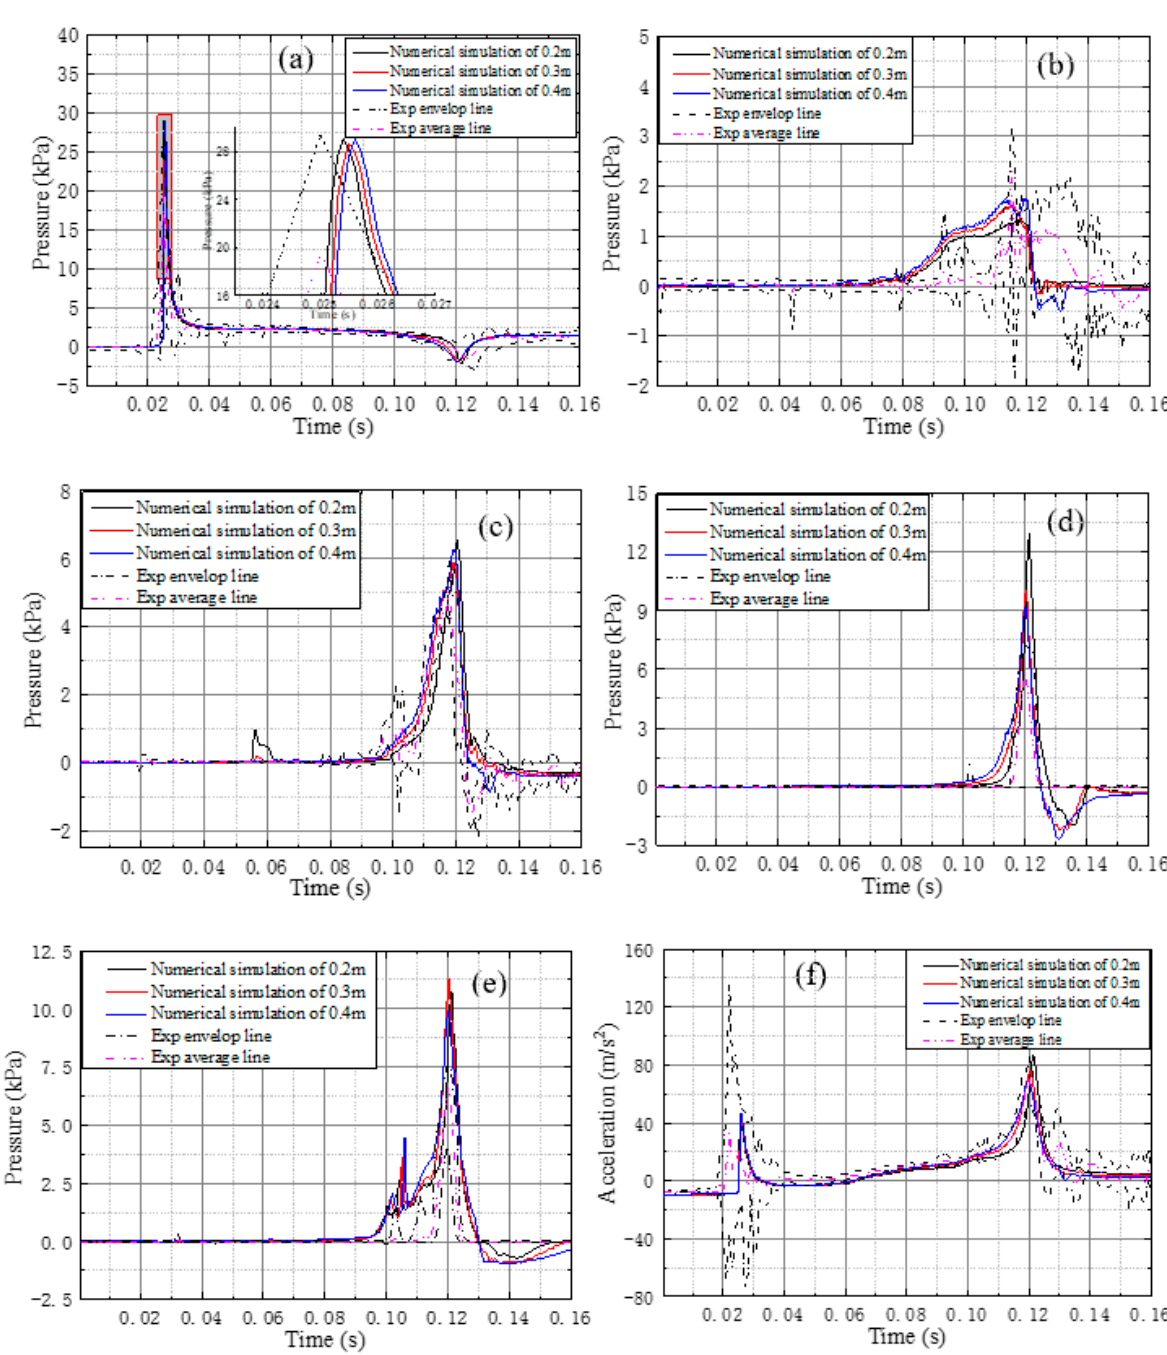
Figure 3. Comparison of pressure and acceleration time-histories simulations with different lengths in the X direction against experimental results (( a – e ) the pressure time histories at p1~p5; ( f ) the acceleration time-history).